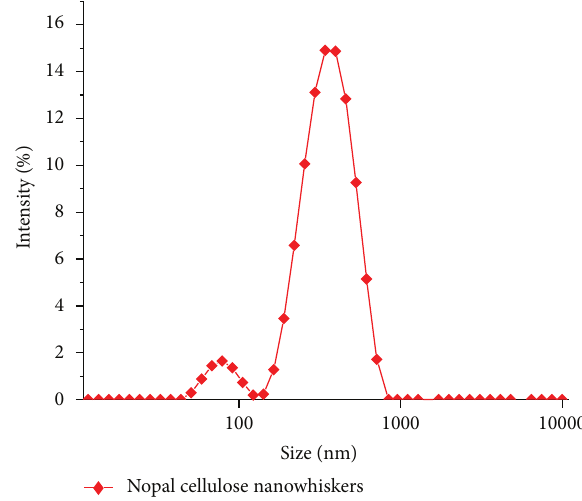
Figure 6: Hydrodynamic size distribution of nopal cellulose